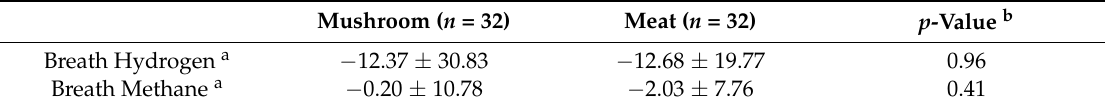
Table 3. Breath hydrogen and breath methane results.